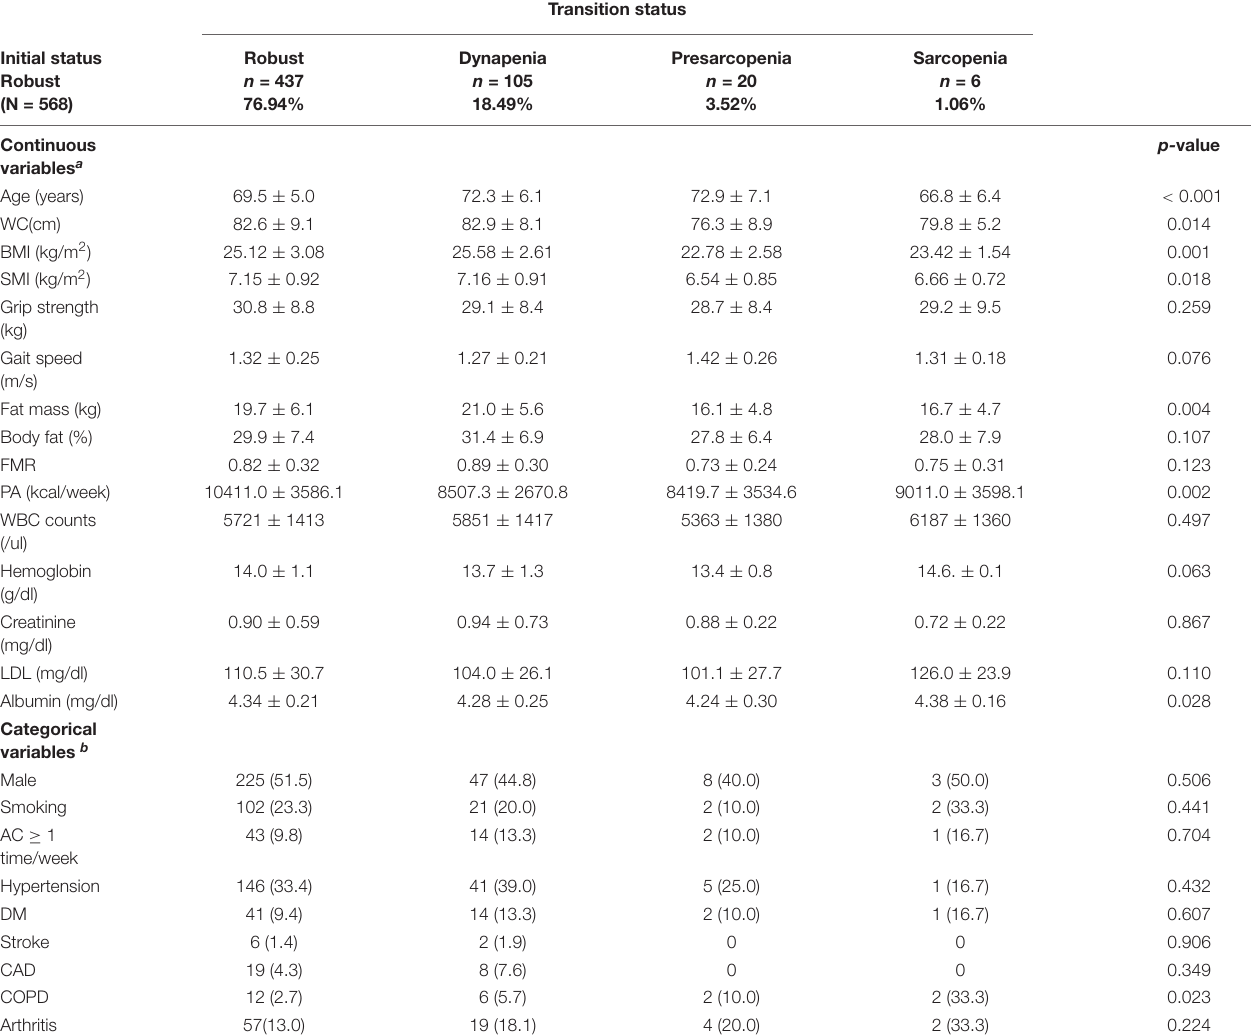
TABLE 1 | Characteristics of participants from robust transition to dynapenia, presarcopenia and